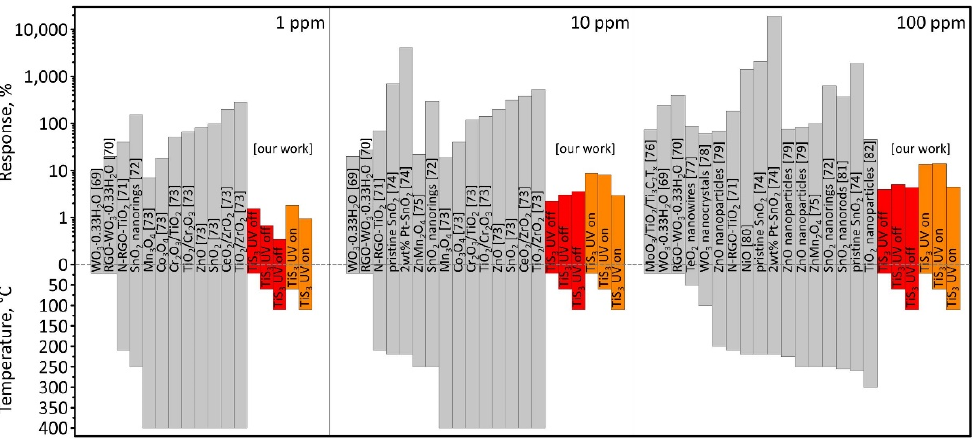
Figure 7. Comparison of experimentally observed chemiresistive responses of various materials to isopropanol at 1–100 ppm concentrations at different operating temperatures. The data are extracted from the literature [69–82] and compared to the results for TiS 3 NW mat-based sensor elements. (1) Responses to 1 ppm of isopropanol. (2) Responses to 10 ppm of isopropanol. (3) Responses to 100 ppm of isopropanol.